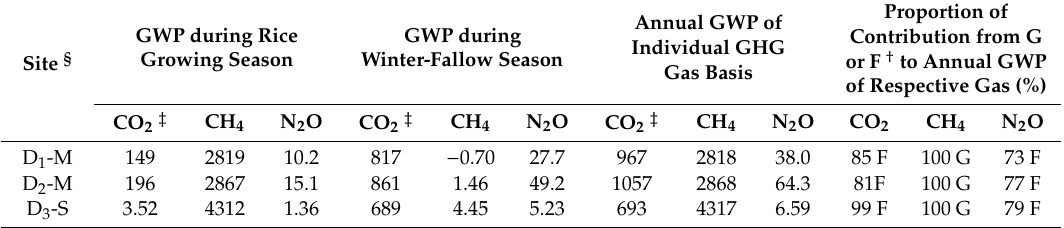
Table 7. Seasonal GWP (g CO 2 equivalent m − 2 ) of CO 2 , CH 4 and N 2 O and their contribution to annual